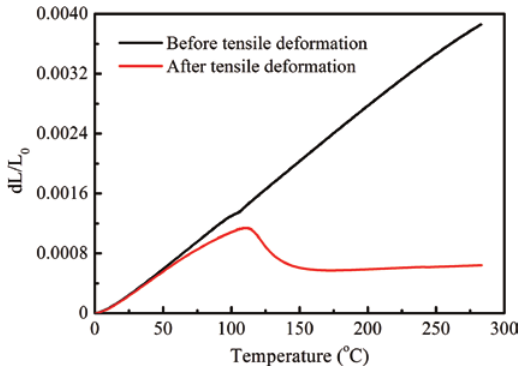
+TiNi /Al composite as a function of p f